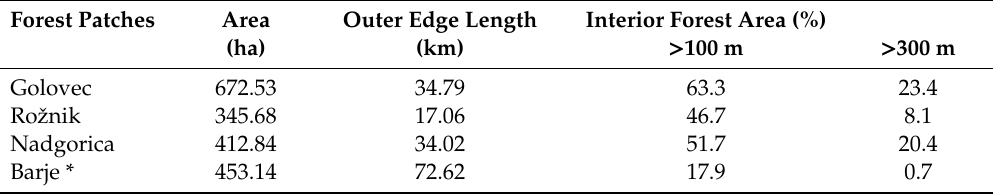
Table 2. Surface of the peri-urban forest patches, the forest outer edge length, and the depth of the interior forest